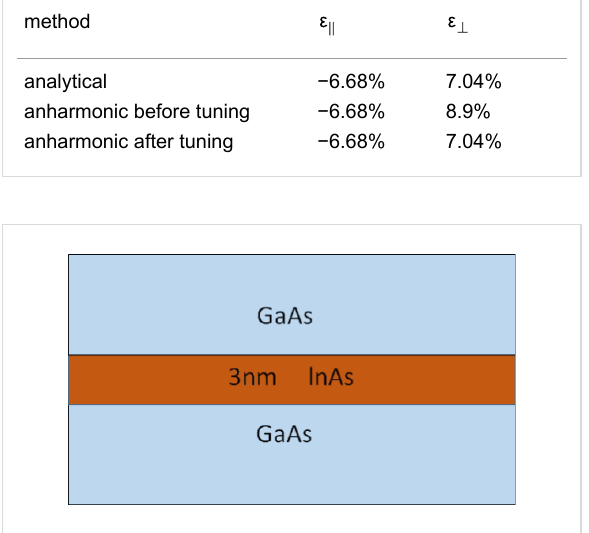
Table 1: Strain calculated for the InAs/GaAs quantum well. Tuning has improved the anharmonic strain results in the quantum well.